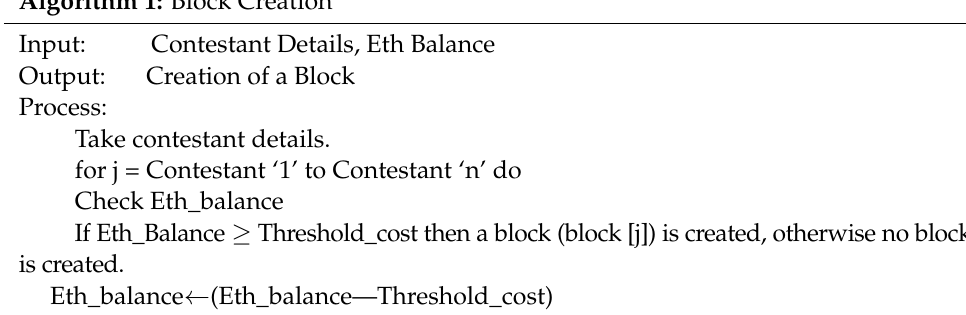
Figure 1. Proposed System